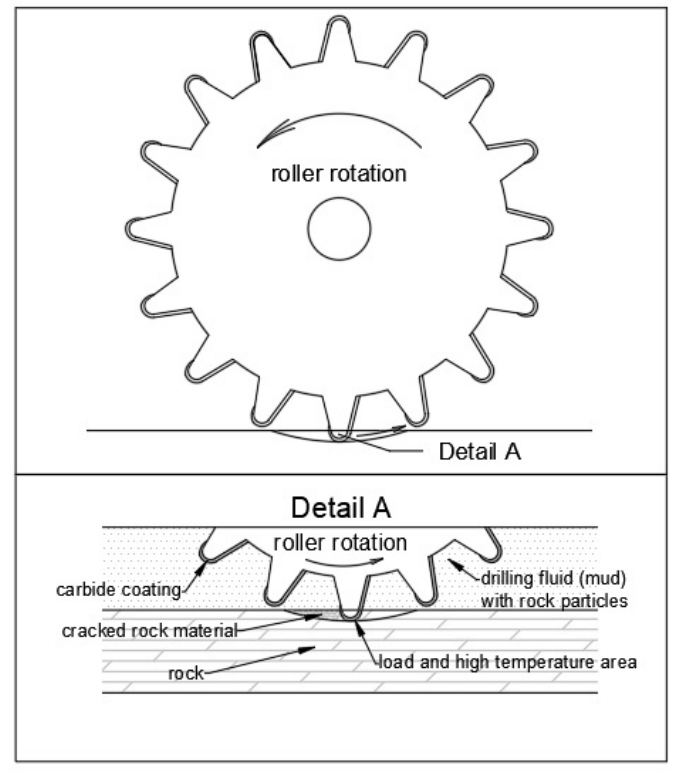
Figure 2. The action of the bit tooth on the rock.